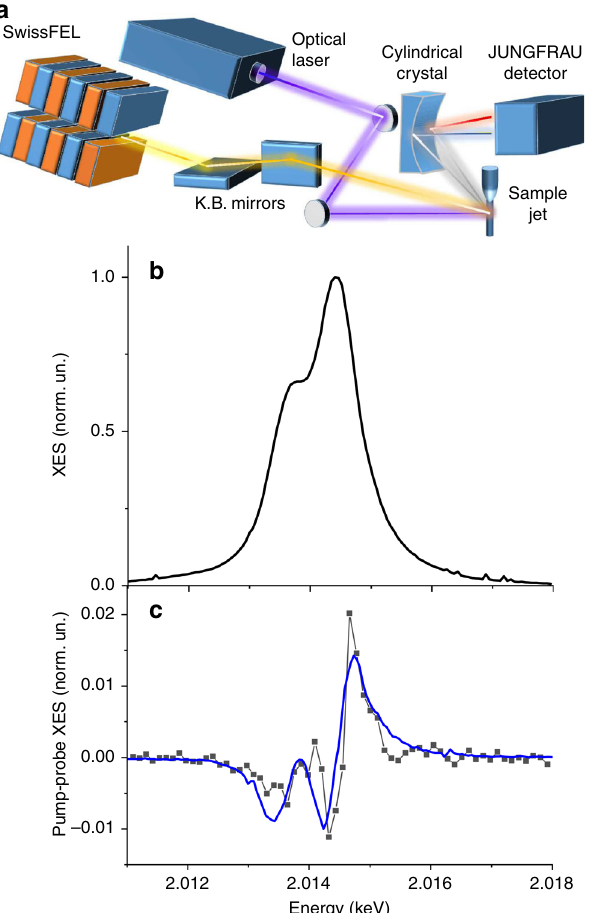
Fig. 3 Pump-probe P K α X-ray emission spectroscopy for [Cu 4 ( PCP ) 3 ] + . a Scheme of the pump-probe P K α X-ray emission experiment at SwissFEL . The X-ray beam from SwissFEL is focused with Kirkpatrick – Baez (K.B.) mirrors and interacts with the sample jet. The same sample volume is excited by an optical laser. X-ray fl uorescence from the sample is dispersed using a cylindrically bent crystal ( von Hamos type geometry) in the horizontal plane and measured using a 2D JUNGFRAU detector. b Ground XES signal (black line) corresponding to the triplet excited state of [Cu 4 ( PCP ) 3 ] + and the signal calculated from the expected shift of emission lines (blue